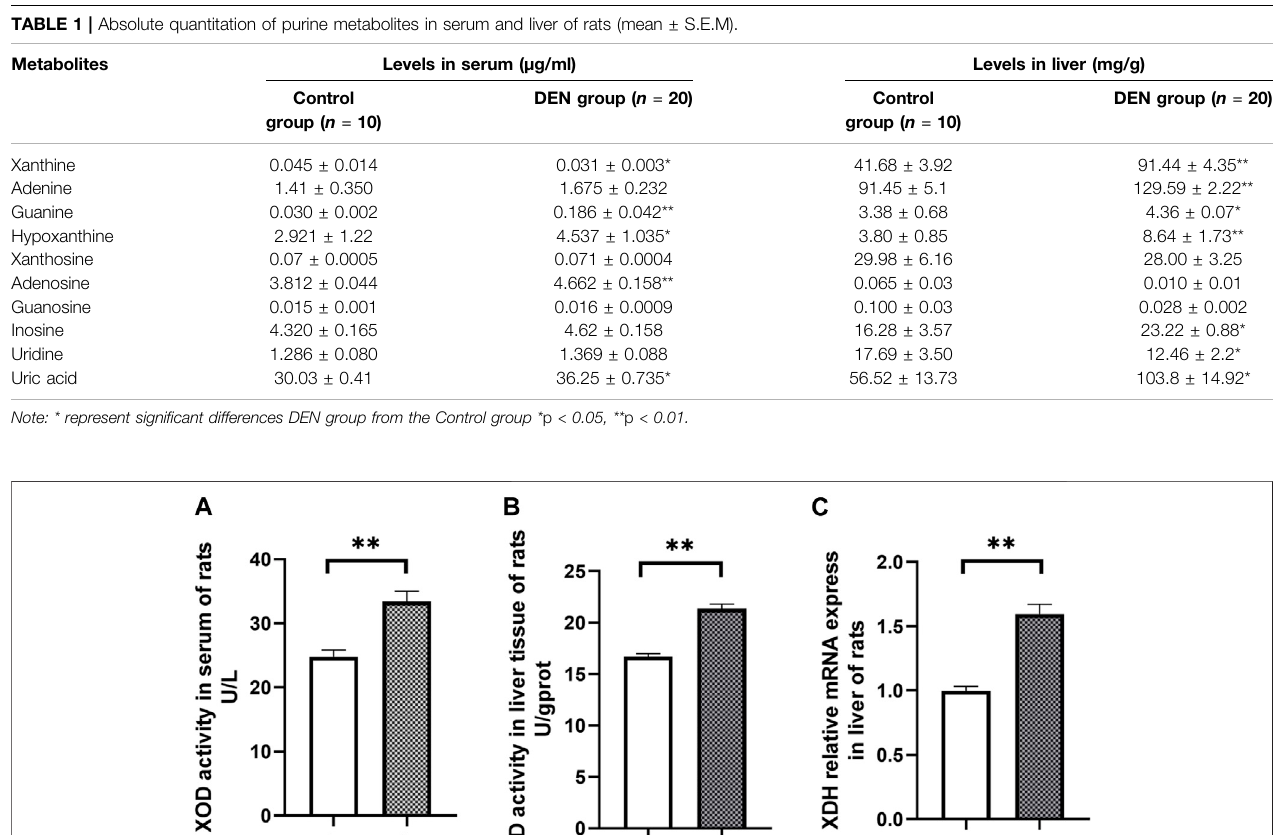
Frontiers in Pharmacology |